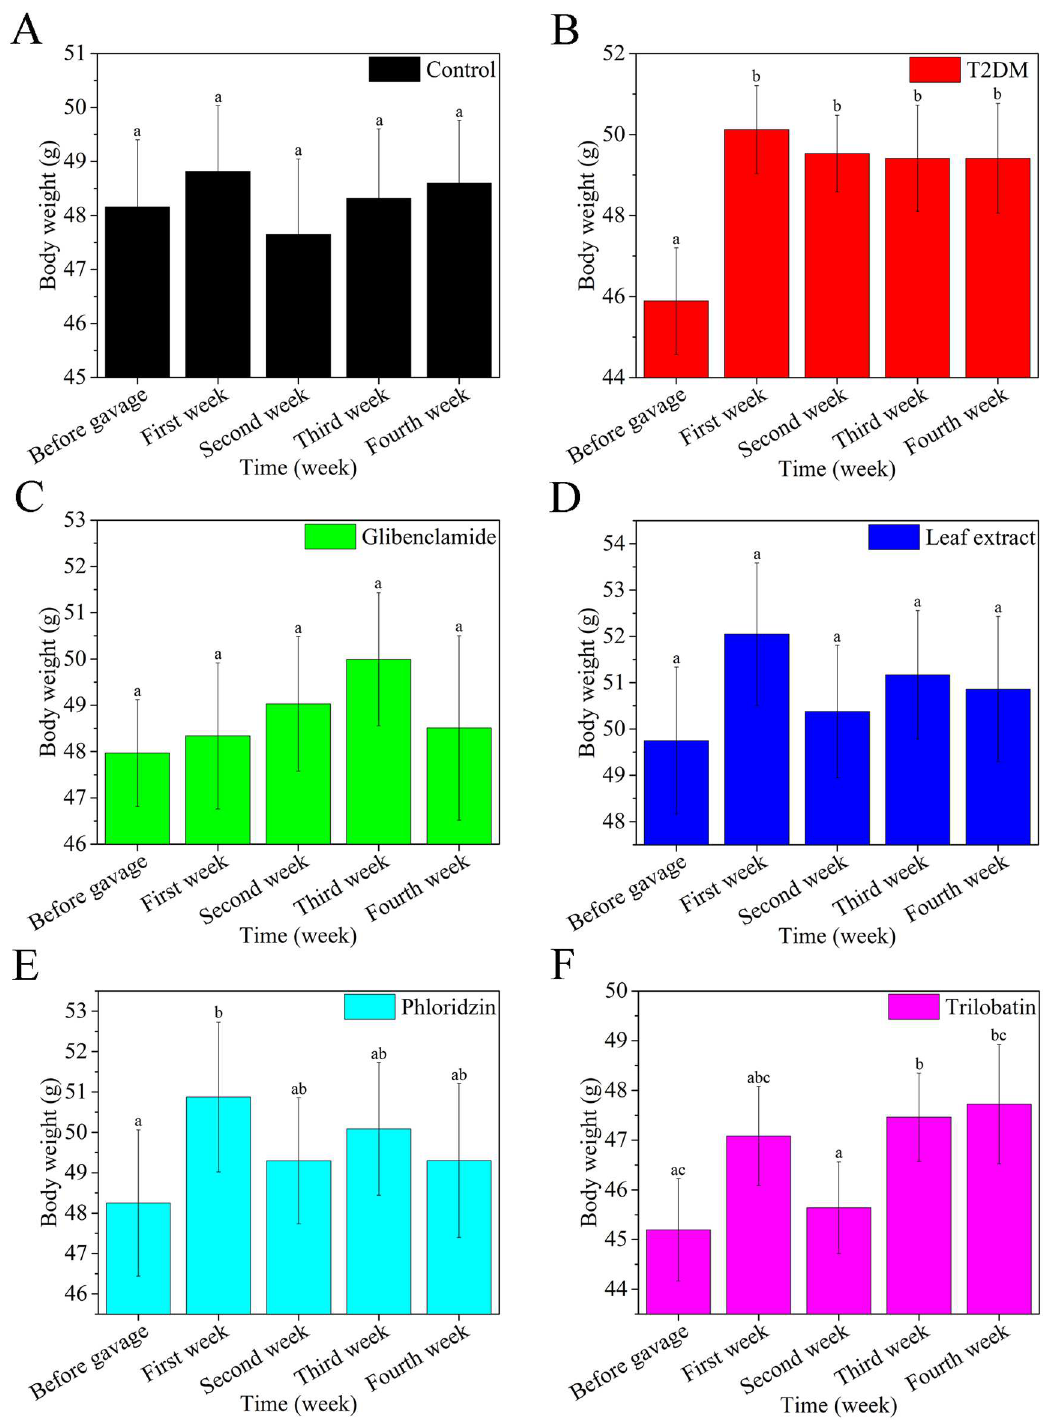
Fig 1. Leaf extractsfrom L . polystachyus Rehd. have no effect on body weight of mice after four weeks of gavage. Body weight of groups control (A), glibenclamide (C), leaf extract (D) and trilobatin(F) were relatively unchanged,while body weight of the T2DM group (B) increasedsignificantly after the first week and stabilizedover the subsequent three weeks. As well as phloridzin(E) slightly increasedat first week and fluctuated after the continue weeks. The data were analyzedusing an ANOVA with repeatedmeasures with a SphericityAssumed or Greenhouse-Geisser correction, and the mean scores for body weight were statisticallyreportedthat control ( F (4, 36) = 2.312, P =